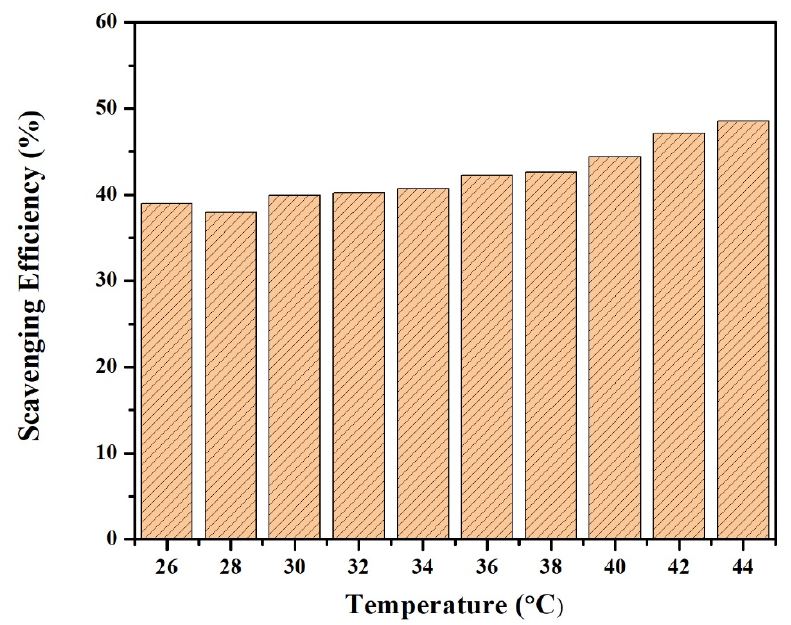
Figure 10. Hydroxyl radical scavenging efficiency of PNI-C 60 in Fenton reaction from 26 to 44 °C with 0.10 mM PNI-C 60 .